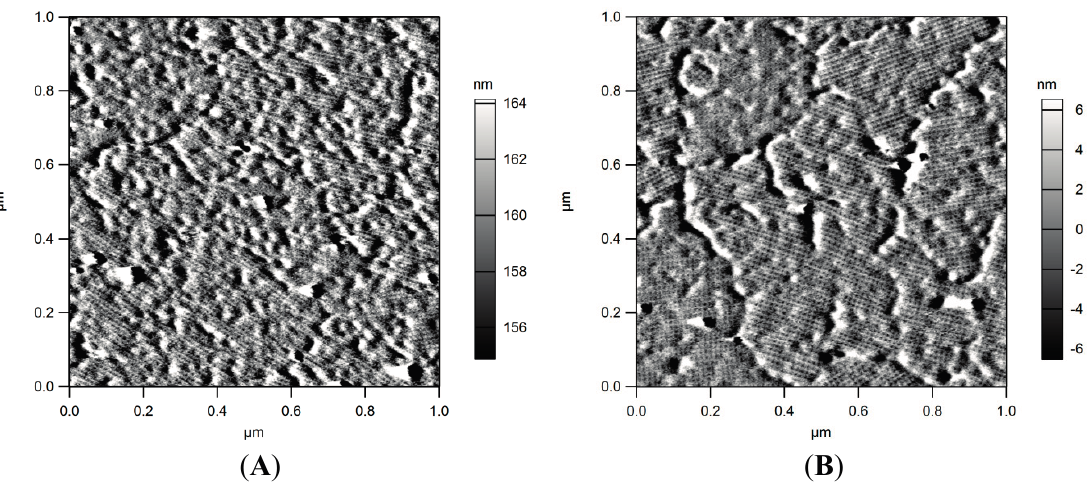
Figure 3. AFM images of SlfB recrystallized on silicon surfaces. ( A ) amplitude image of SlfB prior modification with tryptophan; ( B ) amplitude image of SlfB after crosslinking with tryprophan; S-layer coatings as well as p4-symmetries stay